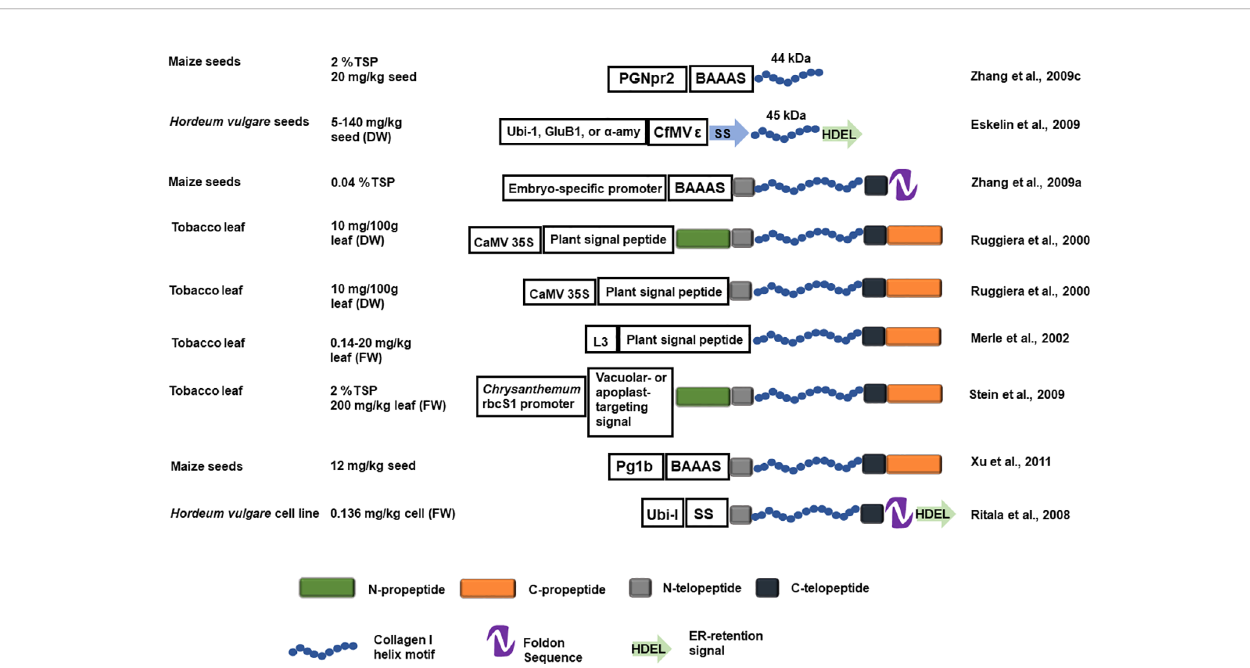
FIGURE 4 | Schematic representation of the recombinant collagen constructs introduced into a plant host system and the estimated yield. The blue helix represents the designed recombinant collagen helix block, the N- and C- propeptide is represented by green and orange rectangles. The N- and C- telopeptide is represented with grey and black rectangles. The NTD and CTD are represented as in Figure 1 . The foldon sequence is represented by a purple hairpin shape and a green arrow represents the ER-retention signal. GluB1, rice glutelin B1 promoter; a -amy, barley a -amylase fusion promoter 46 /4-6; BAAAS, Barley a -amylase signal sequence; Ubi-I, maize ubiquitin promoter and fi rst intron; SS, Arabidopsis basic chitinase signal sequence; ϵ , the 5'UTR of Cocksfoot mottle virus; Pg1b, maize embryo speci fi c globulin-1 promoter; PGNpr2, embryo-speci fi c maize globulin-1 promoter; L3, L3